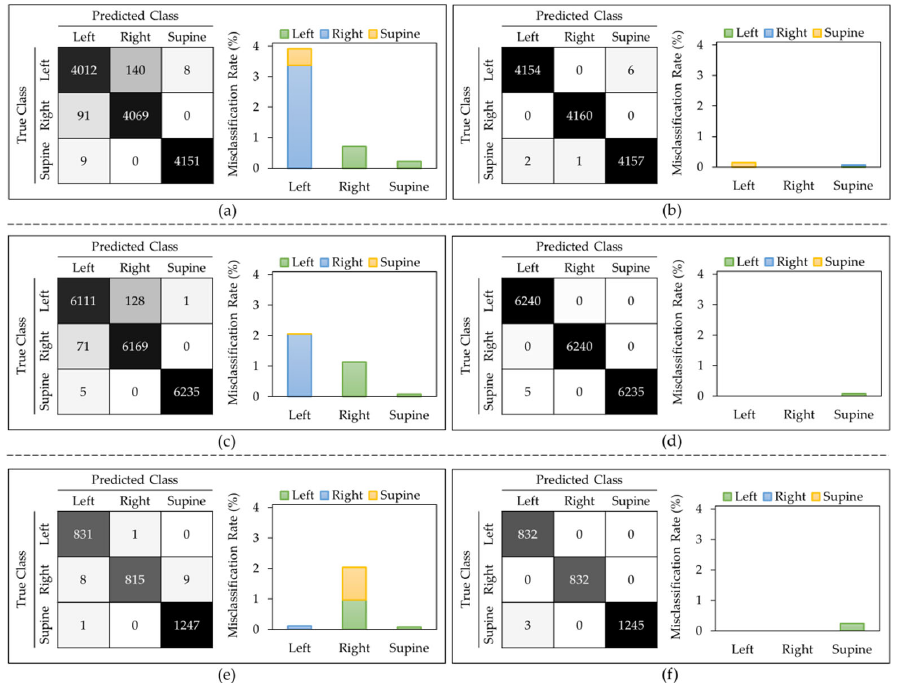
Figure 5. Best 2D models: Confusion matrix and misclassification rates of all 5 down ‐ sampling runs for ResNet ‐ 18 ( a ) LOSO and ( b ) 5 ‐ fold. Confusion matrix and misclassification rates of all 5 over ‐ sampling runs for ResNet ‐ 18 ( c ) LOSO and ( d ) 5 ‐ fold. Confusion matrix and misclassification rates 5 over-sampling runs for ResNet-18 ( c ) LOSO and ( d ) 5-fold. Confusion matrix and misclassification of class weights model for ShuffleNet ( e ) LOSO and ( f ) 5 ‐ fold. rates of class weights model for ShuffleNet ( e ) LOSO and ( f )